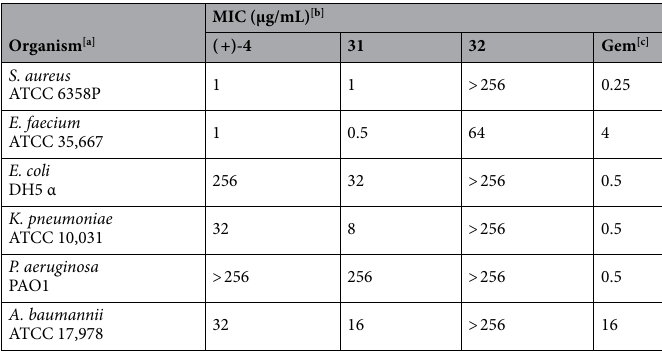
MIC (µg/mL) [b] (+)-4 31 Gem [c]